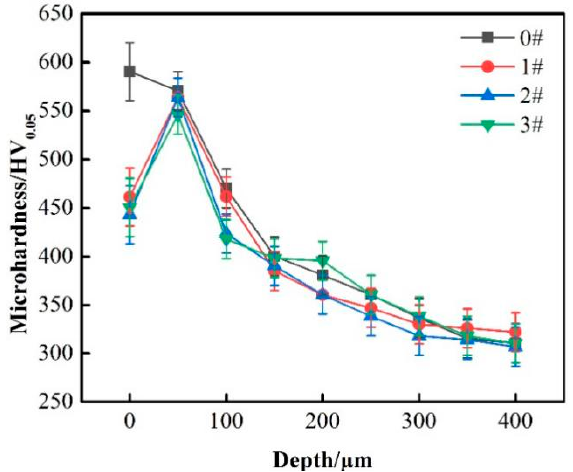
Figure 7. The cross-sectional microhardness of samples.